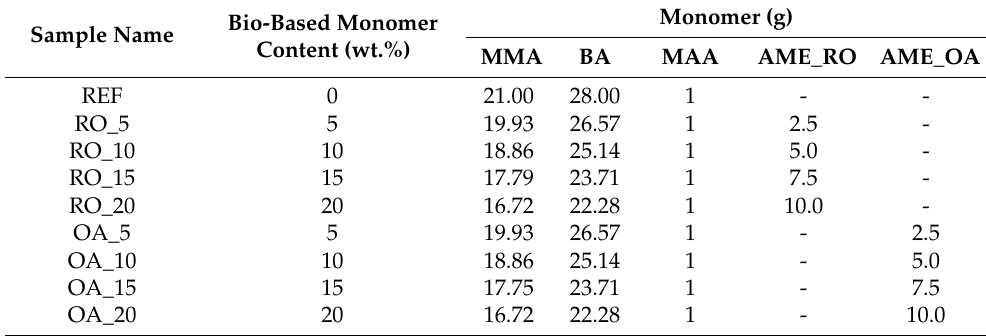
Table 1. Names of latex samples and the respective amounts of monomers in the monomer